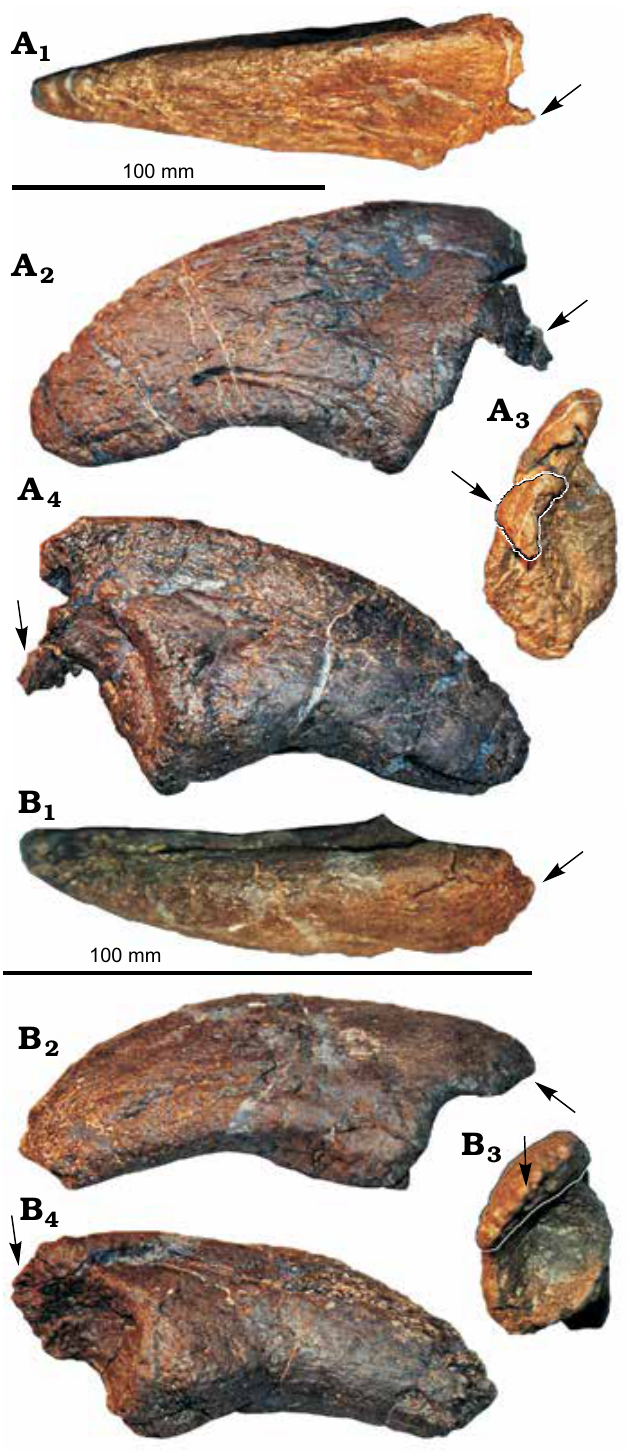
Fig. 3. Overgrowth type 1 (arrows) in right pedal unguals I ( A ) and III ( B ) of the camarasaurid sauropod SMA 0002 from Upper Jurassic Morrison Formation, Howe-Stephens Quarry, Wyoming, USA. Overgrowth projects proximally from the proximal articular surface. Note the medial to me- diodorsal position of the overgrowths on the proximal articular surfaces. Unguals shown in dorsal (A 1 , B 1 ), medial (A 2 , B 2 ), proximal (A 3 , B 3 ), and lateral (A 4 , B 4 ) views. Photos taken by Esther Premru (Mönchaltorf, Switzerland) and modified from Tschopp et al.